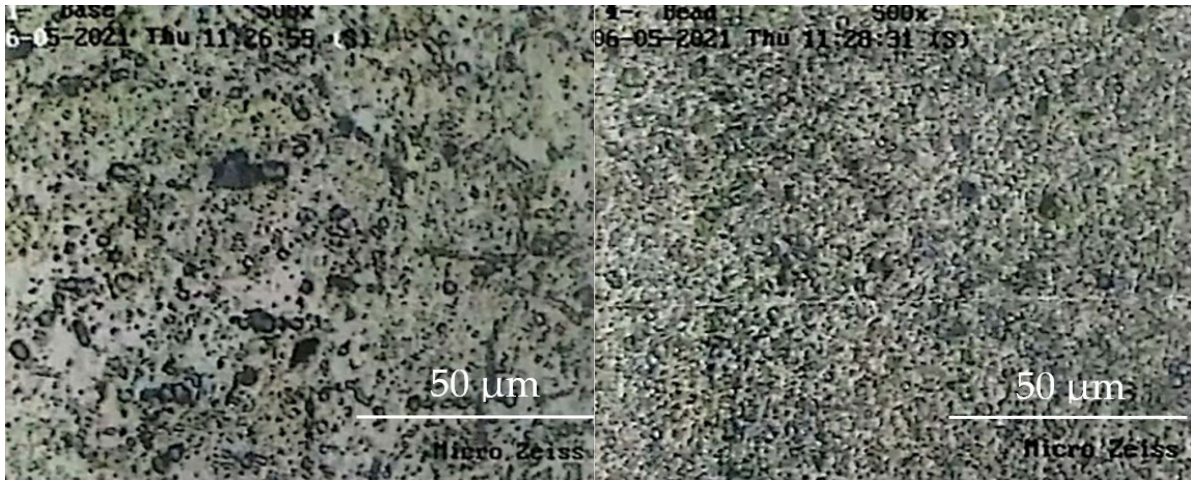
Figure 7. Optical micrographs of AA5451 (base metal) and FSW region at an optimum level.